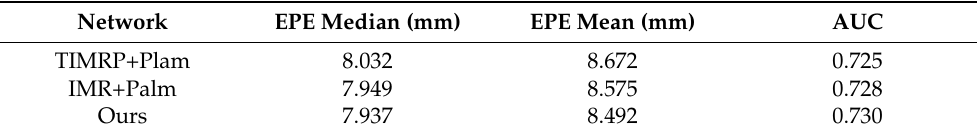
Figure 6. Comparative experiment of the effectiveness of the Palm connecting with a finger. Table 3. Error analysis of connecting Palm with a single